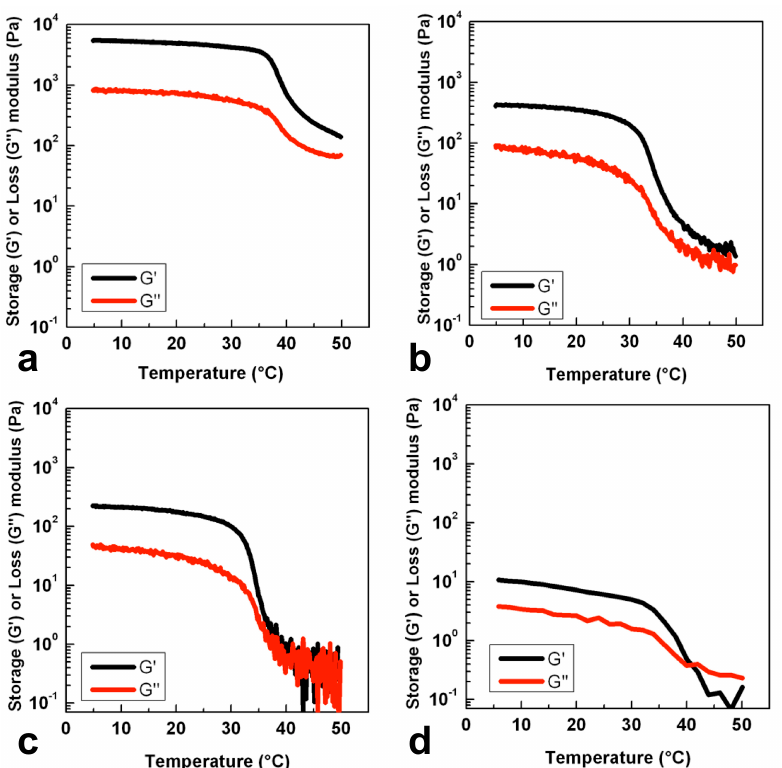
Figure 2. Temperature dependence of storage modulus (G) and loss modulus (G ′′ ) during cooling process for hydrolysis product GG 4 ( a ), GG 6 ( b ), GG 8 ( c ) and GG 24 ( d ) dispersed in water at 5% w/v . Experiments were performed at 0.5 Hz and 1% of strain.